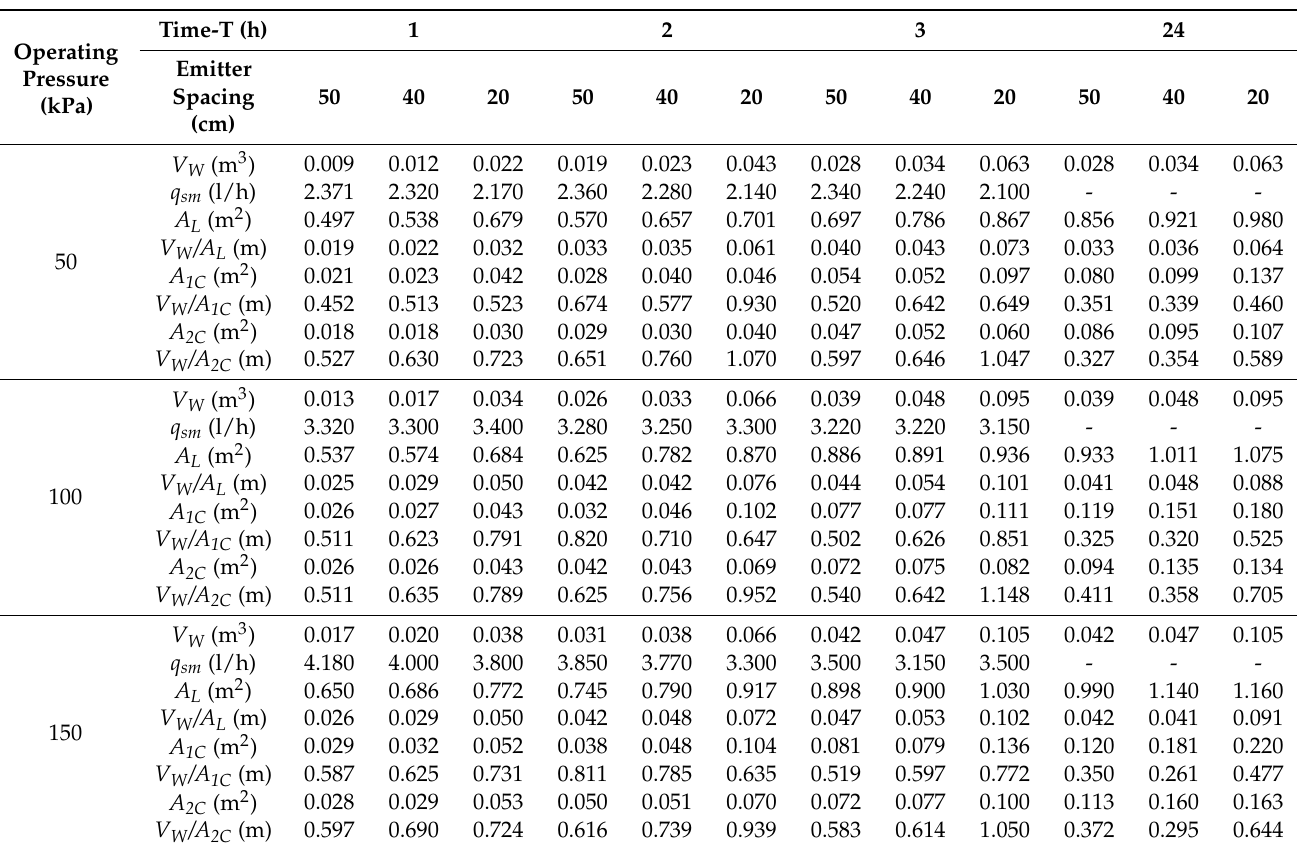
Table 3. Volumes of water discharged ( V w ), the mean rate of the discharged water per emitter ( q sm ), and wetted area measured along the longitudinal direction ( A L ), initial ( A 1C ), and final ( A 2C ) cross-sections were obtained in all the experiments. The ratios between the discharged water to the wetted area are also